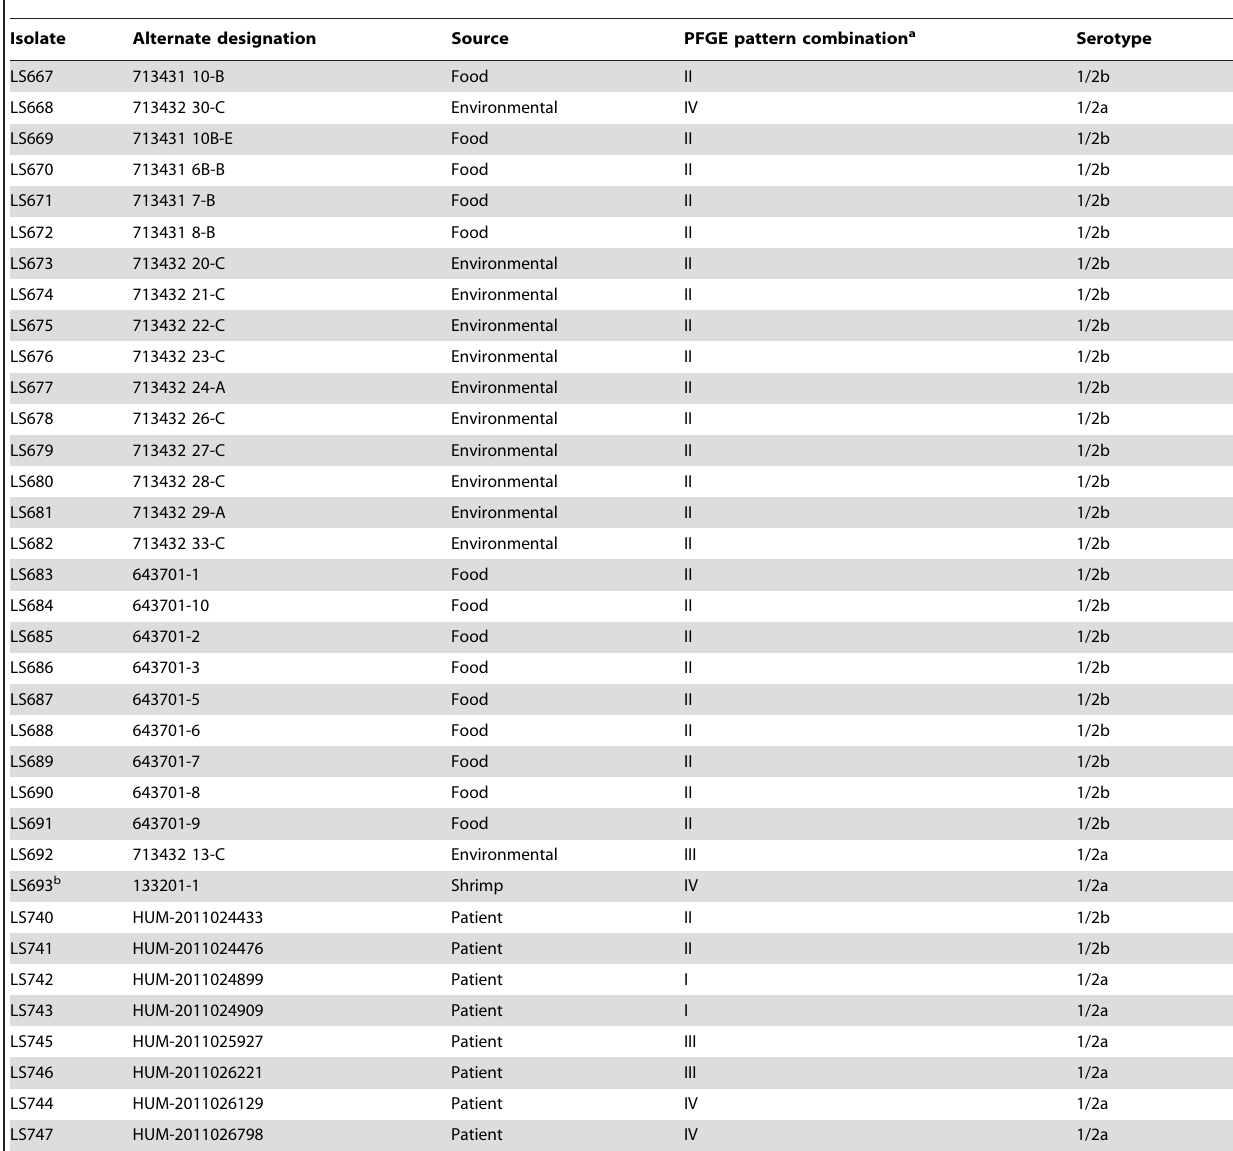
a PFGE pattern combinations were assigned based on the AscI pattern and the ApaI pattern as described in Figure 1 and Table 2. b Non-outbreak